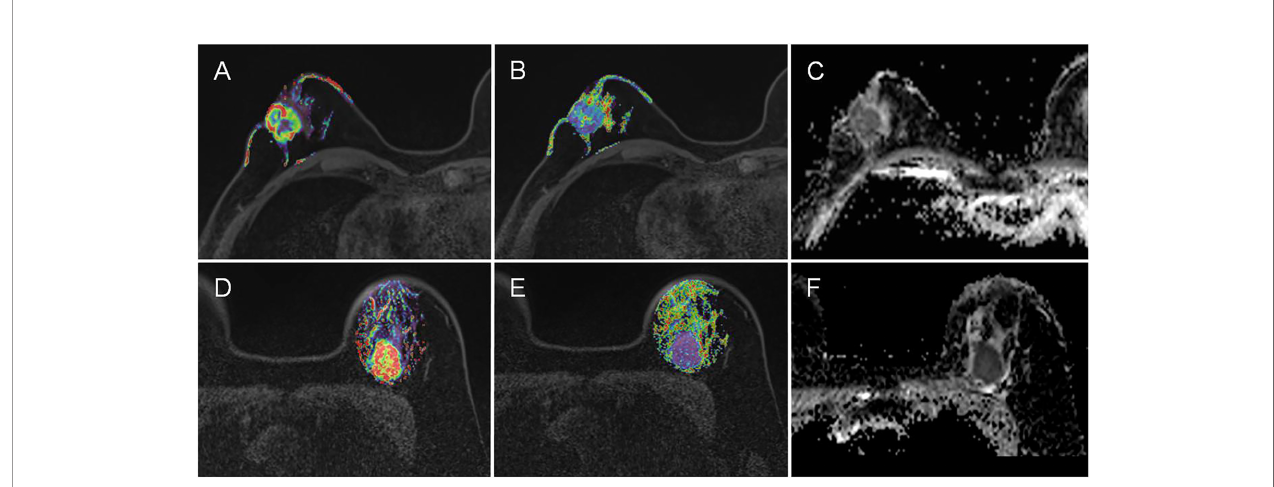
FIGURE 3 | Representative K ep , TTP and ADC images in luminal A and TNBC. (A – C) are the images of K ep , TTP and ADC from a luminal A patient, with mean values of 0.48 min -1 , 0.70 min, and 0.89×10 -3 mm 2 /s, respectively. (D – F) are the images of K ep , TTP and ADC from a TNBC patient, with mean values of 0.94 min -1, 0.58 min, and 0.70×10 -3 mm 2 /s,